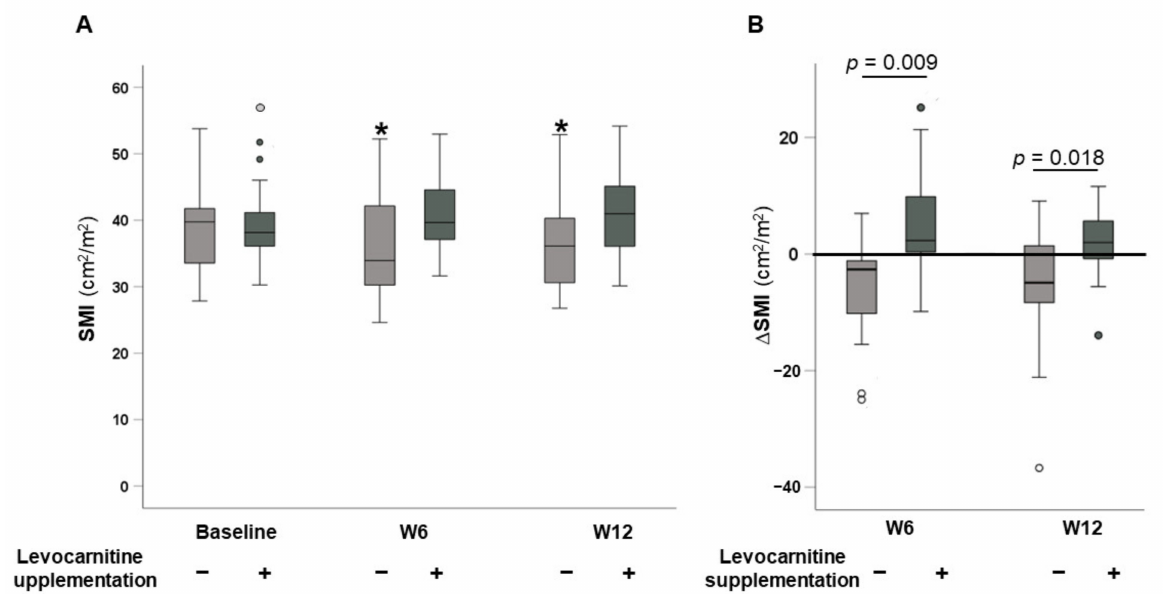
Figure 2. ( A ) Time course of skeletal muscle index (SMI) values and ( B ) changes in SMI from baseline ( ∆ SMI) between patients without and with levocarnitine supplementation at 6 and 12 weeks after initiating lenvatinib therapy. * p < 0.05 vs.